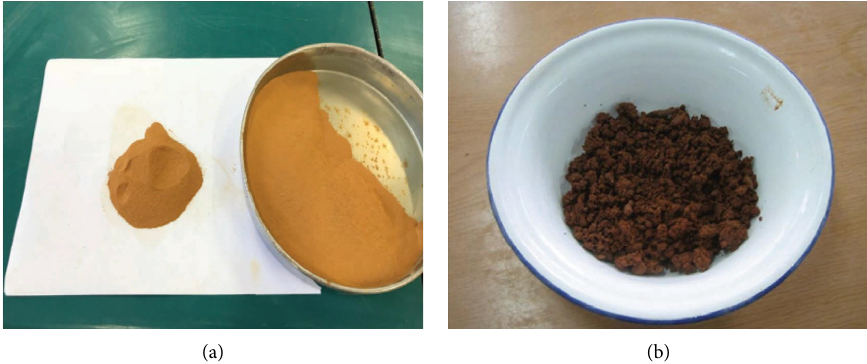
Figure 1: Red clay specimen. (a) Dry red clay sample. (b) Sheng soil dish.